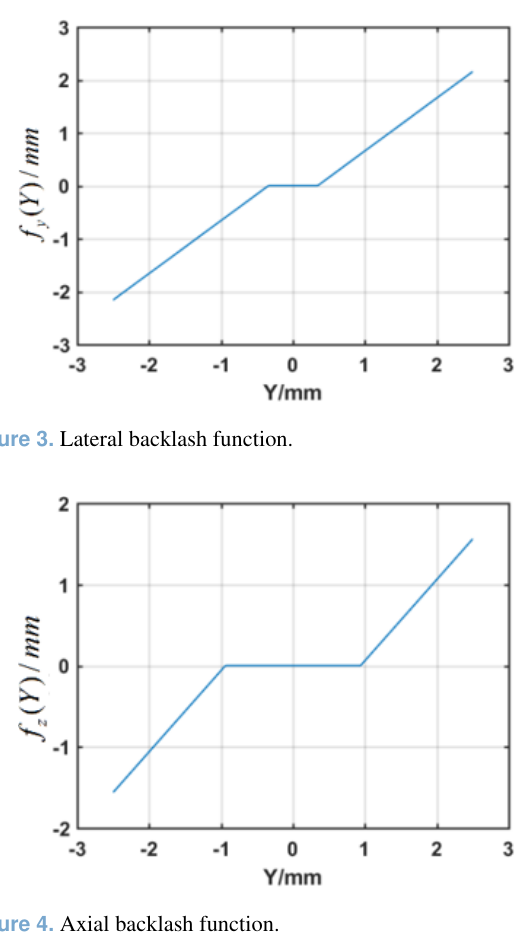
Figure 4. Axial backlash function.